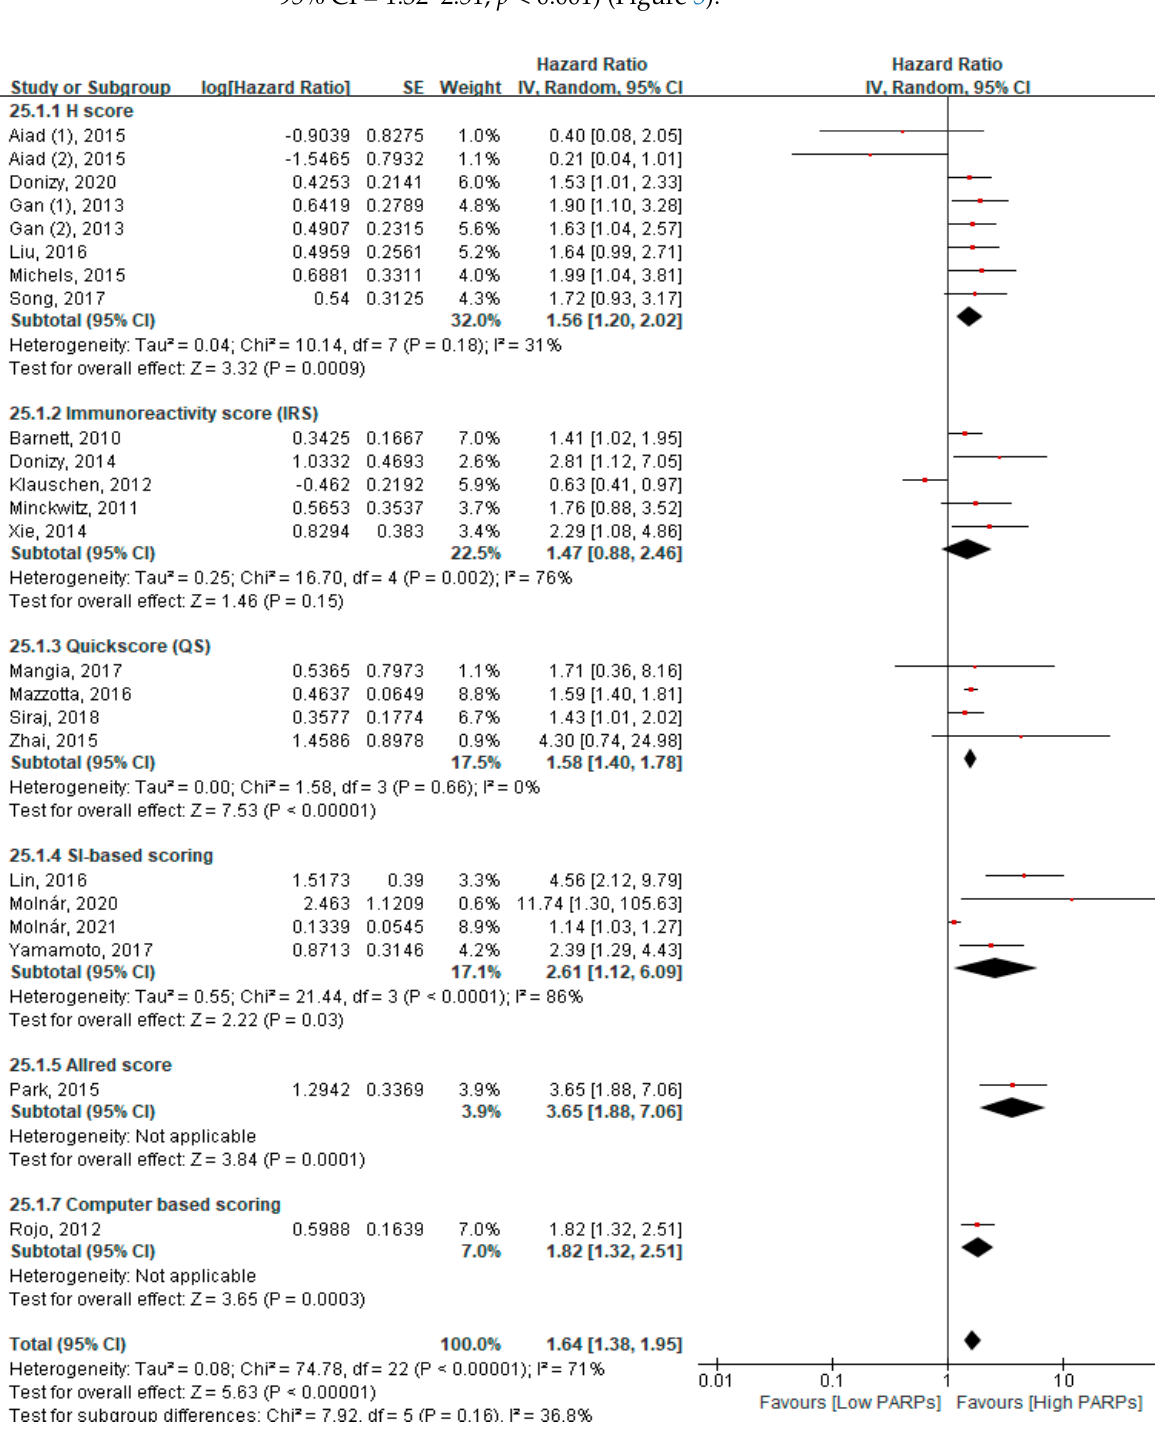
Figure 5. The subgroup analysis between the PARP expression and overall survival according to the scoring methods.